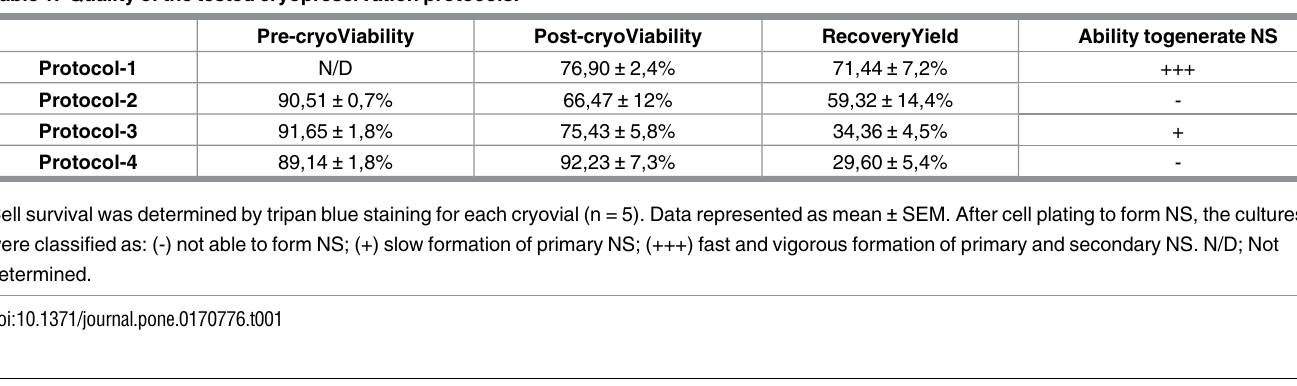
Table 1. Quality of the tested cryopreservation